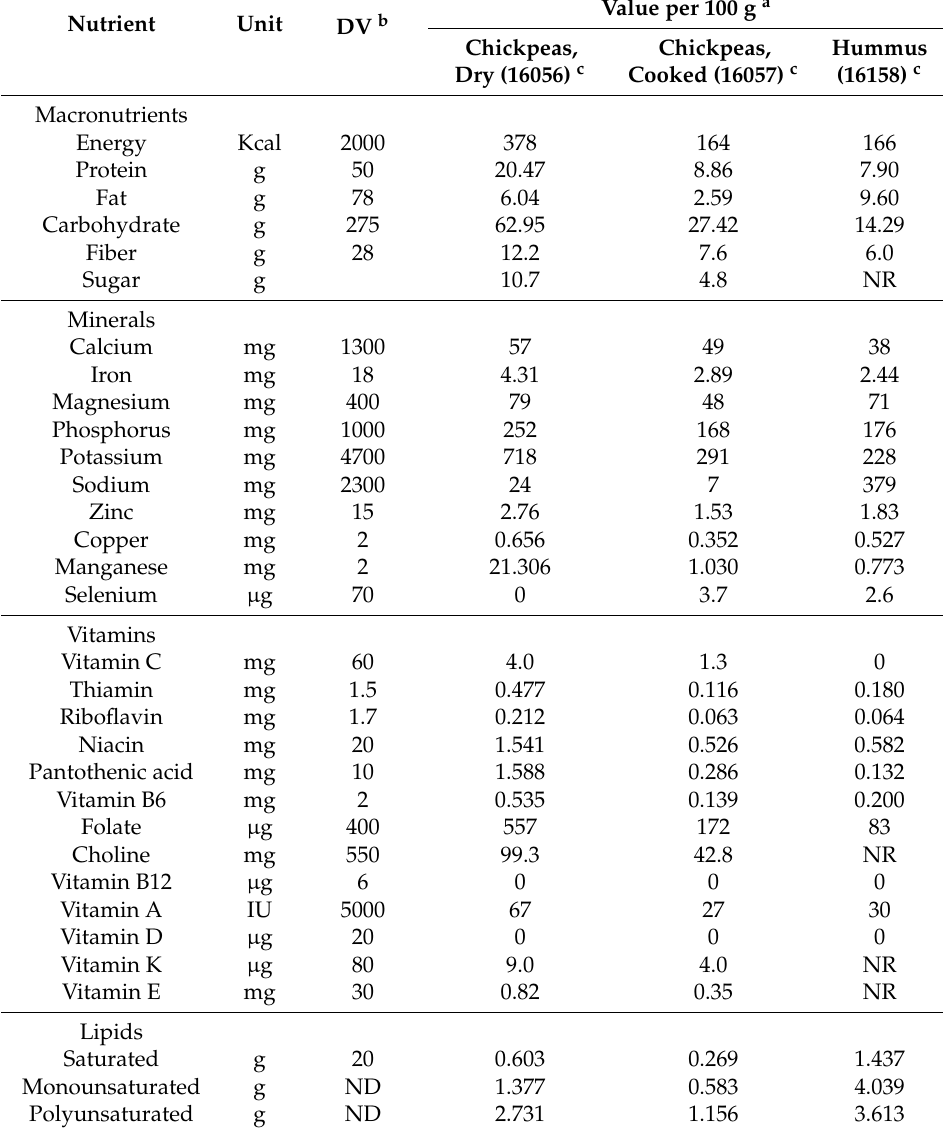
Table 1. Nutritional profile of chickpeas and